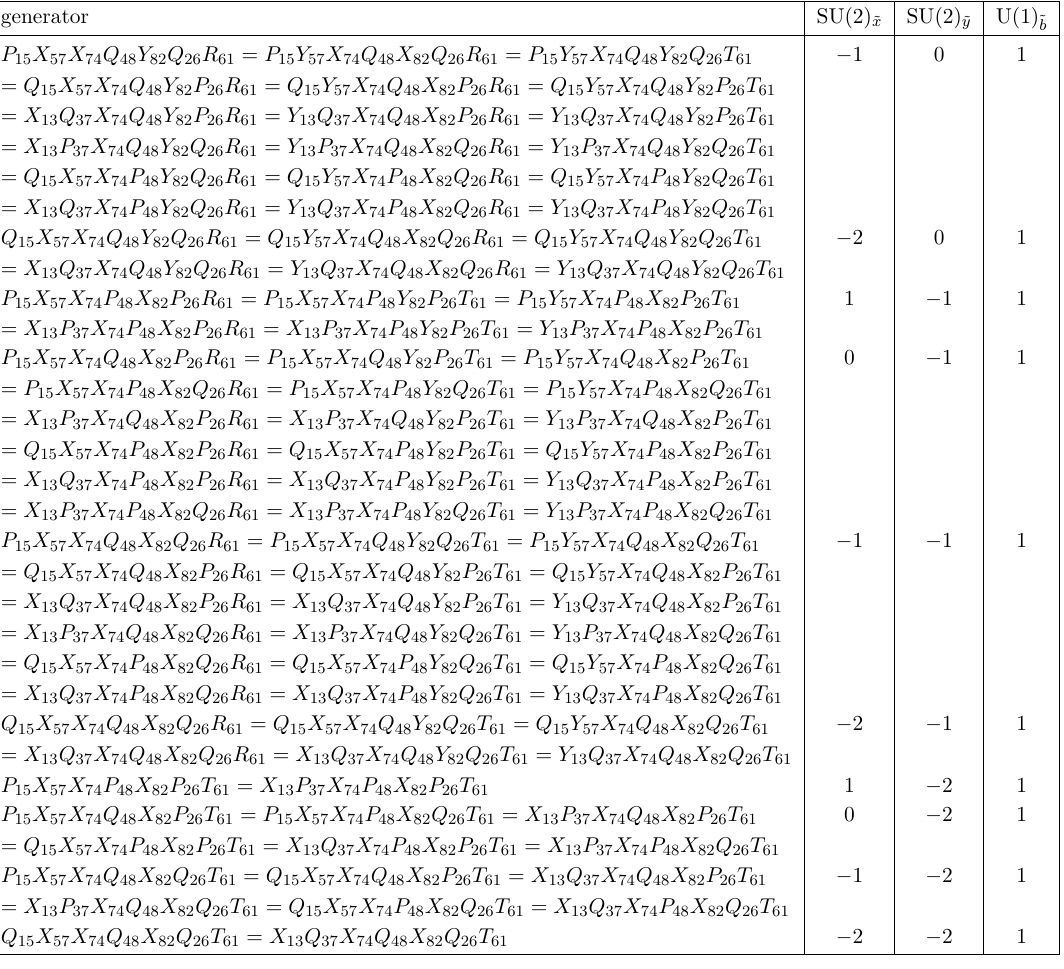
Table 38 . The generators in terms of bifundamental chiral fields for Model 9 (Part 2)